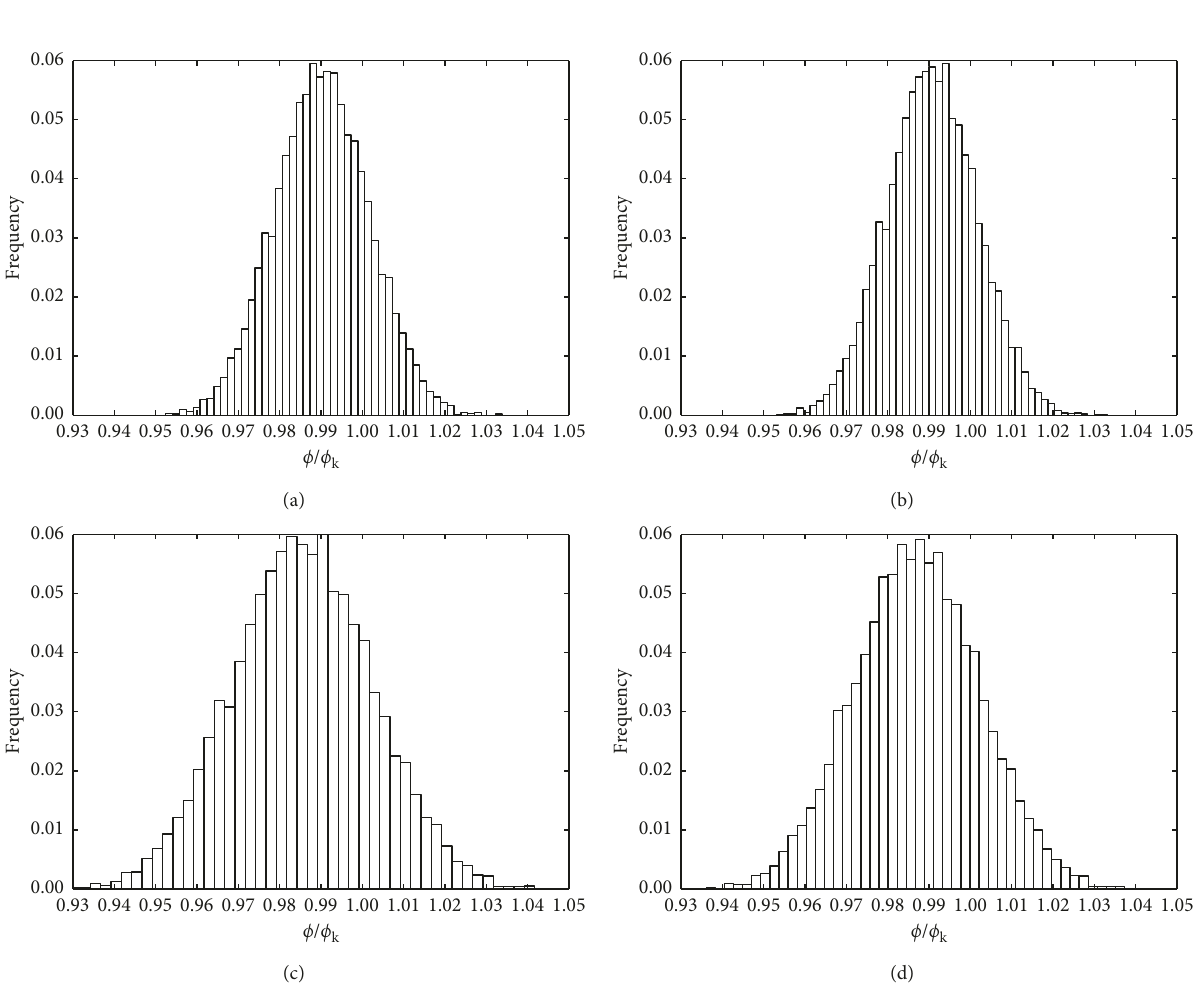
Figure 1: Frequency histogram of ϕ/ϕ � 50 of Section b. (a) Q235: d > 16 ∼ 40mm, (b) Q235: d > 40 ∼ 60mm, (c) Q345: k for slenderness ratio λ d > 16 ∼ 35 mm, and (d) Q345: d > 35 ∼ 50